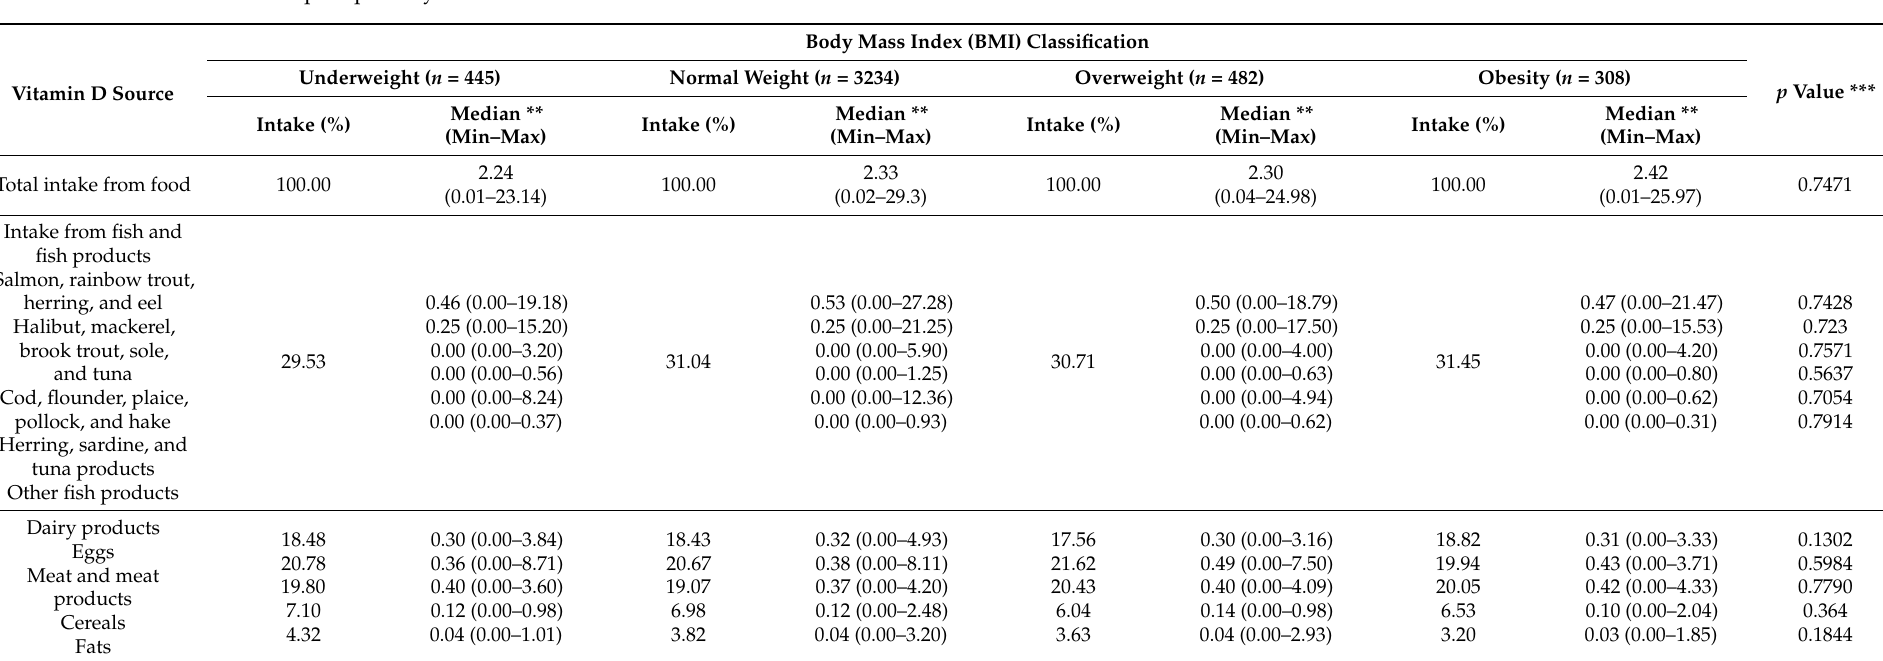
Table 6. Comparison of vitamin D intake from various food groups ( µ g per day) in the sub-groups of underweight, normal weight, overweight and obese female post-primary school